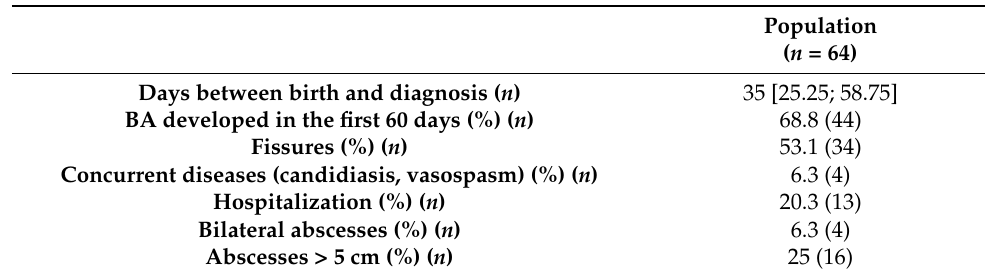
Table 2. Clinical characteristics.